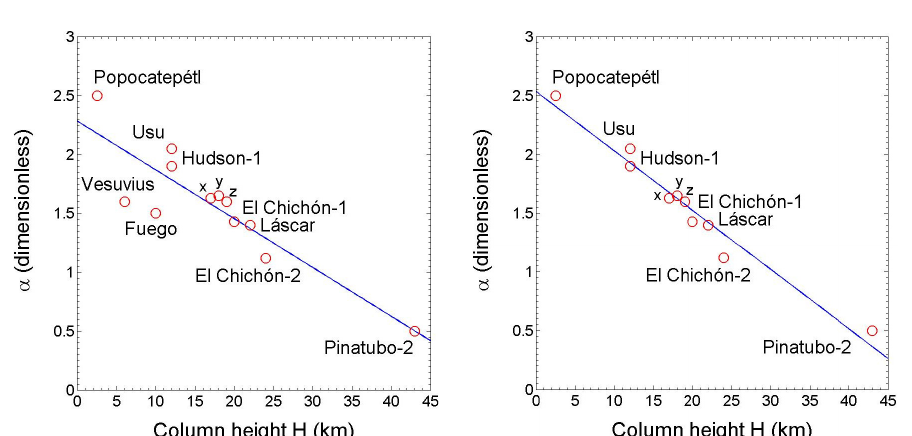
Fig. 7. Best linear fit (solid line) between the parameter α and the eruptive column maximum heights H for several eruptions. (a)